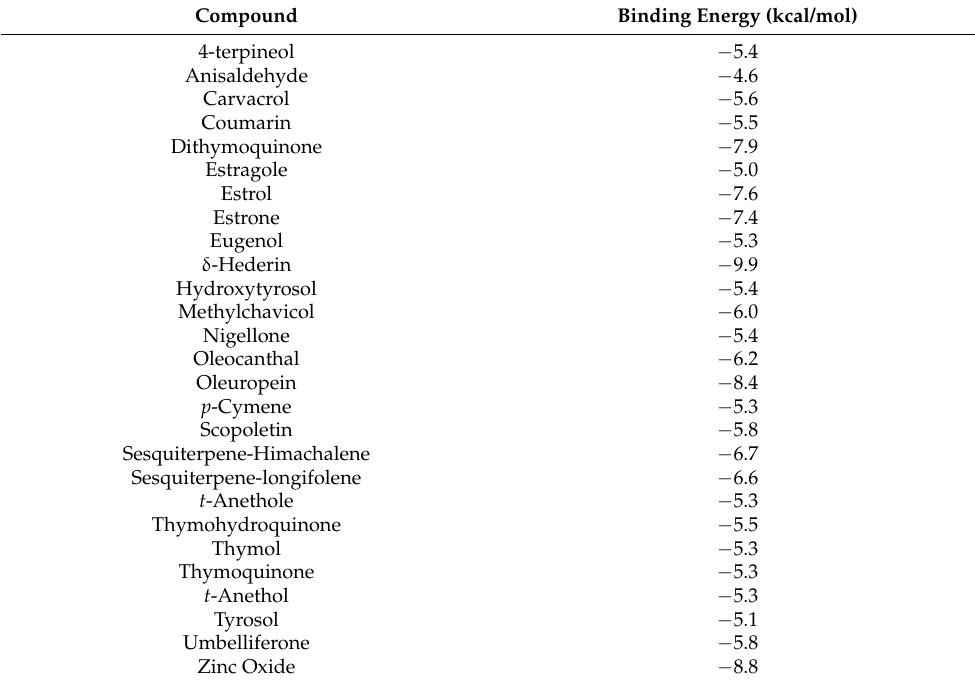
Table 1. Molecular docking results; binding energies of constituent